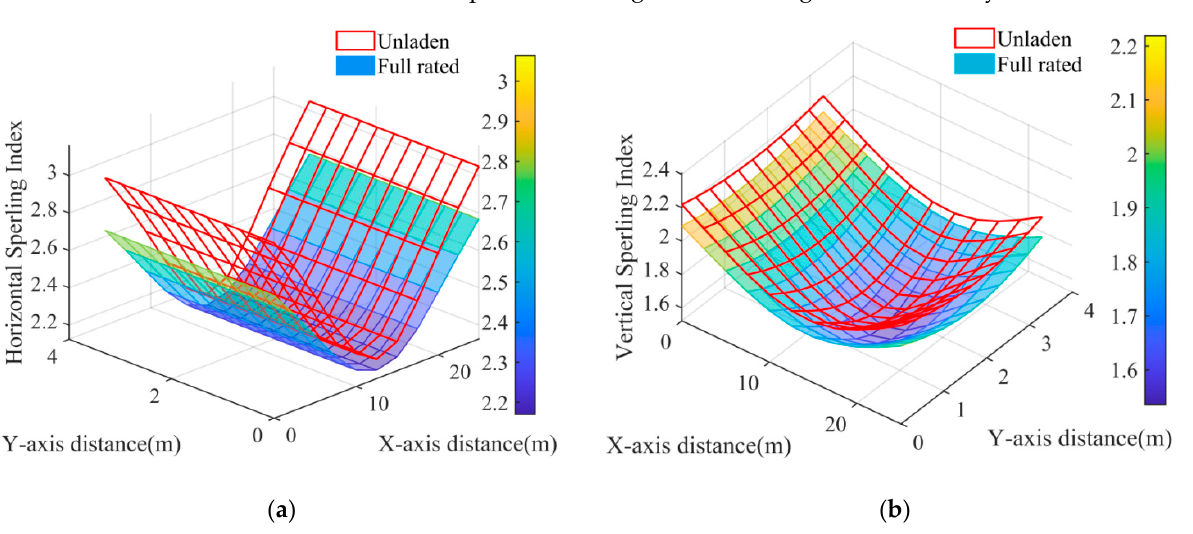
Figure 9. Zonal distribution of car-body Sperling index influenced by the addition of the car-body mass using PEM: ( a ) horizontal Sperling index; ( b ) vertical Sperling index.